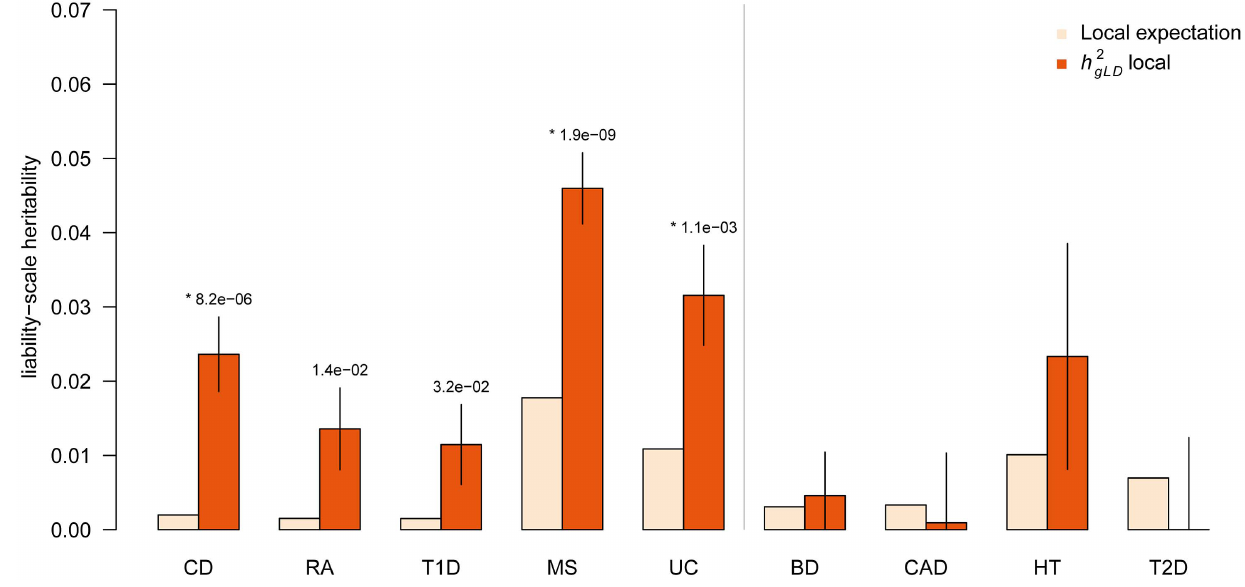
Figure 3. Heritability of known autoimmune disease loci. Components of heritability inferred at previously known autoimmune trait loci not identified for focal trait. Local expectation computed based on fraction of genome analyzed. (*) indicates statistically significant increase over expectation after accounting for nine tests, respectively. Error bars show analytical standard error of estimate. All analyzed autoimmune traits (Crohn’s Disease, Rheumatoid Arthritis, Type 1 Diabetes, Multiple Sclerosis, and Ulcerative Colitis) all exhibit significant increase in local h 2 non-autoimmune traits (Bipolar Disorder, Coronary Artery Disease, Hypertension, Type 2 Diabetes) exhibit no significant increase. Autoimmune traits excluded the well-studied MHC